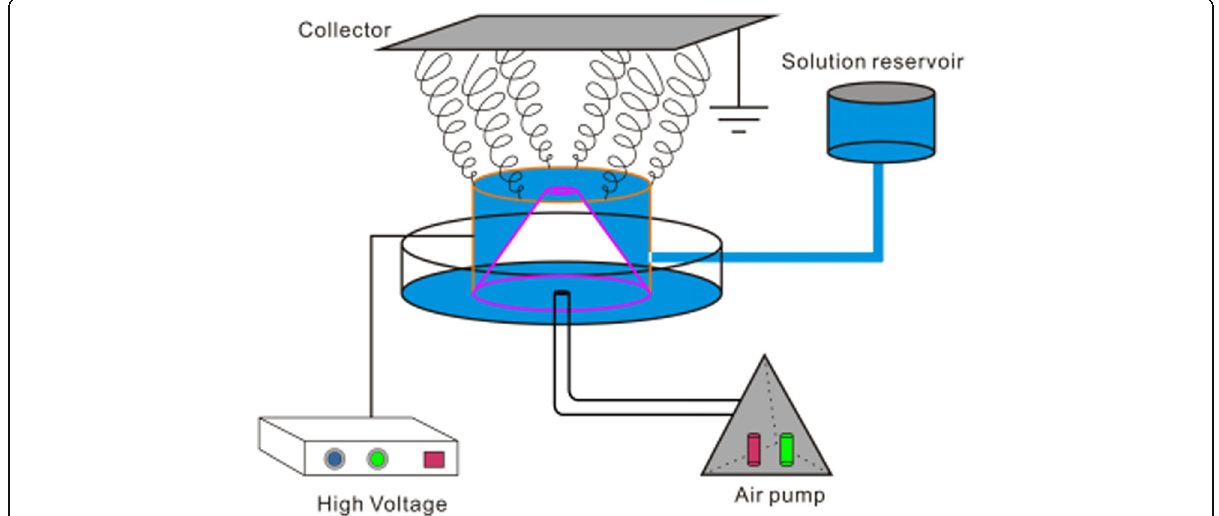
Fig. 1 Schematic of the MFSE